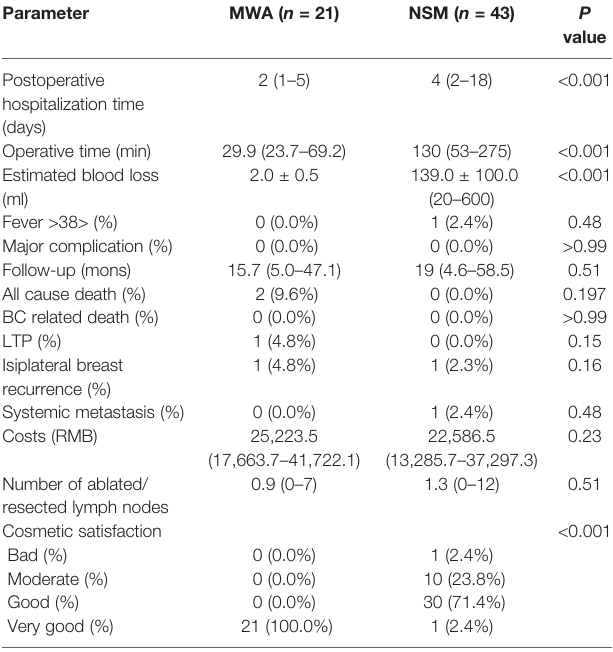
TABLE 3 | Postoperative outcomes and follow-up. TABLE 4 | Univariable and multivariable analyses of predictors of tumor progression after